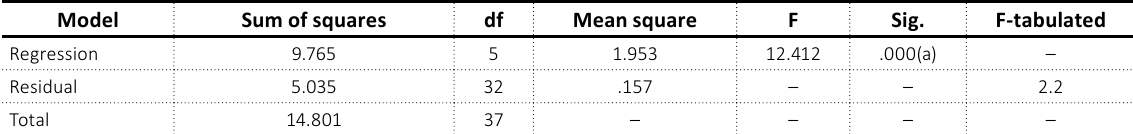
Table 8. Analysis of variance (ANOVA) for independent variables and the dependent variable Model